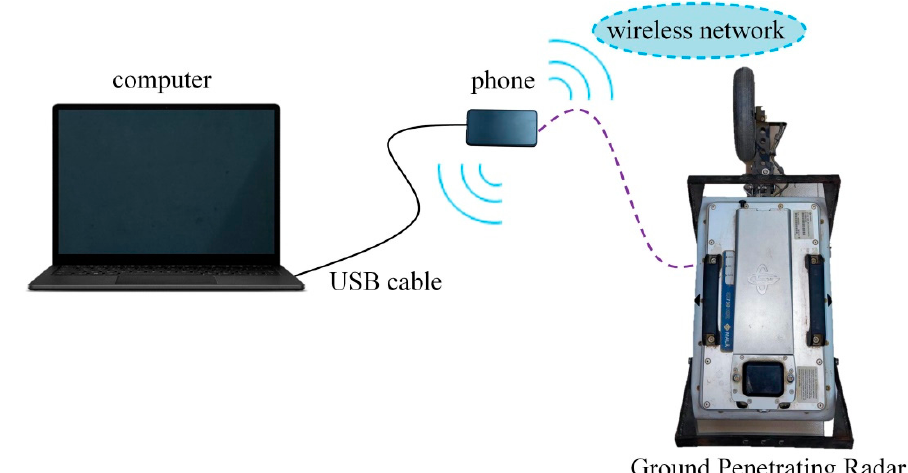
Figure 5. Components of the GPR real-time detection system.